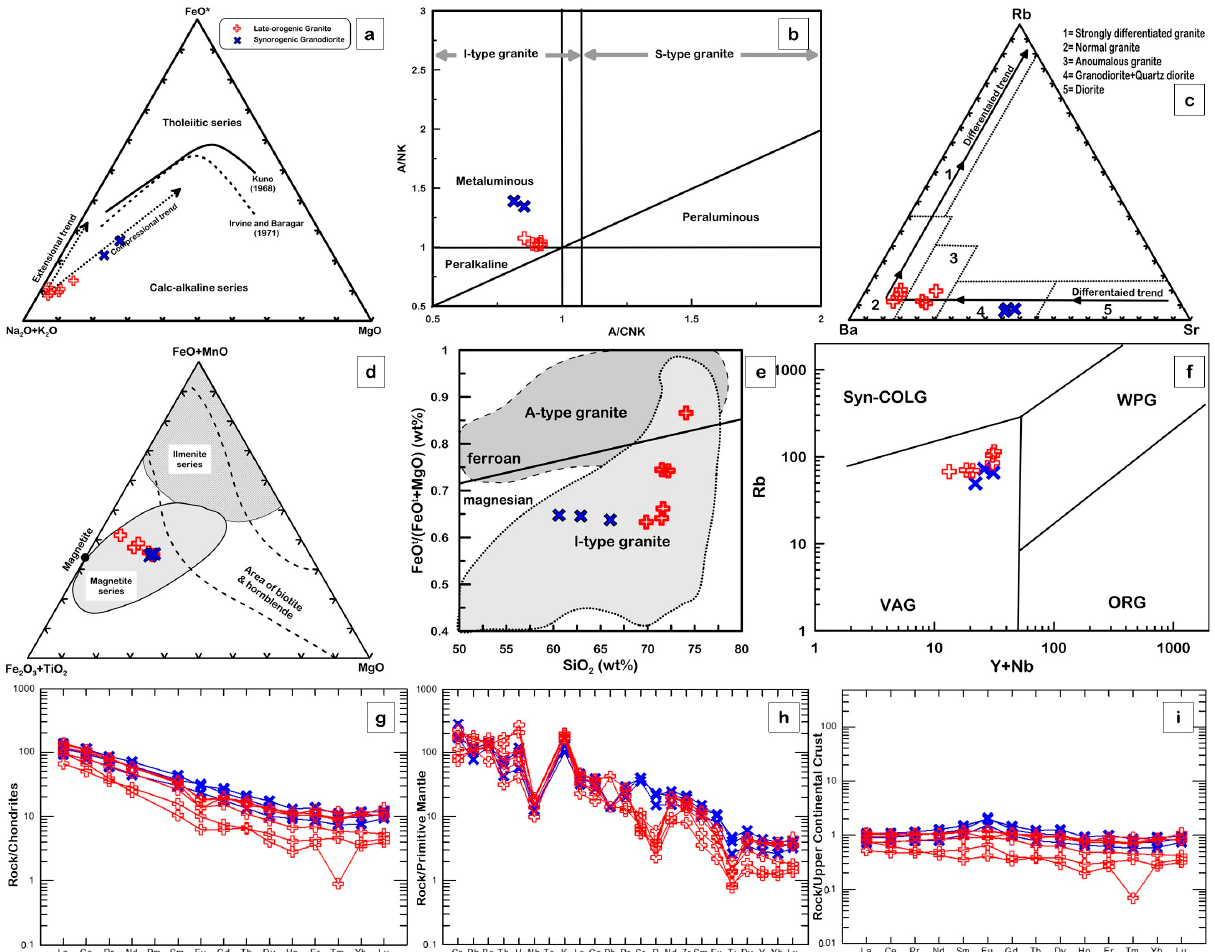
Figure 12. Geochemical diagrams of the synorogenic and late orogenic granitoid rocks: ( a ) AFM diagram [48,50], the trends of compressional and extensional environments after Petro et al. [51]. ( b ) Alumina saturation index (ASI) in the studied granitoid rocks. ASI = 1 from Shand [52], ASI = 1.1 from Chappell and White [53]. ( c ) Ba-Rb-Sr ternary diagram after El Bouseily and El Sokkary [54]. ( d ) Fe 2 O 3 + TiO 2 -FeO + MnO-MgO diagram after Ishihara [55]. ( e ) SiO 2 vs. FeO t /(FeO t + MgO) dia- gram after Frost et al. [58]. ( f ) Rb vs. (Y + Nb) tectonic discrimination diagram, after Pearce et al. [56]. ( g ) Chondrite-normalized REE patterns [46]. ( h ) Primitive mantle-normalized trace element patterns [46]. ( i ) Upper continental crust (UCC)–normalized REEs [57].